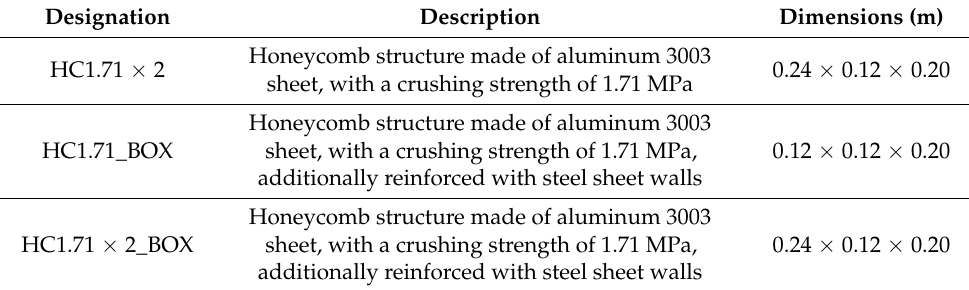
Table 7. Specifications of the energy-absorbing